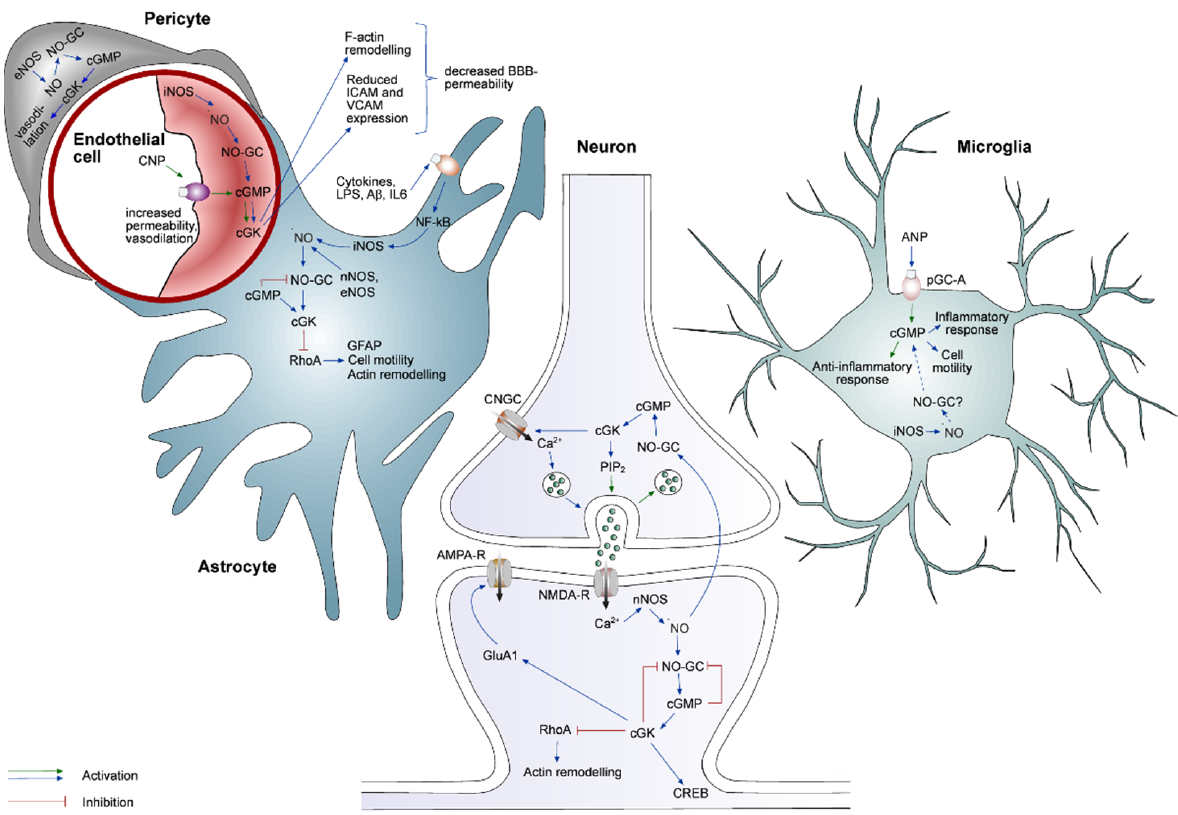
Figure 2. The functional roles of the cGMP signaling pathways in neurons, astrocytes, microglia, endothelial cells, and pericytes (see text for detailed description). AMPA: α -amino-3-hydroxy-5- methyl-4-isoxazolepropionic acid receptor; GluA1: ionotropic glutamate receptor of AMPA type, sub- unit 1; CREB: cAMP response element-binding protein; GFAP: glial fibrillary acidic protein; IL6: interleukin 6; LPS: lipopolysaccharide; NF- κ B: nuclear factor kappa B; NMDA-R: N -methyl- D -as- partate-receptor; RhoA: Ras homolog family member A; ICAM: intercellular adhesion molecule; VCAM: vascular cell adhesion molecule; all other abbreviations are explained in the figure legend for Figure 1.